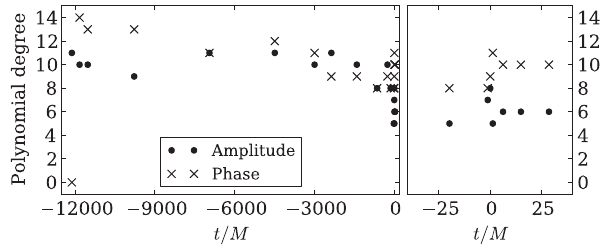
FIG. 13. The optimal degree of each polynomial from a least squares fit at each empirical time. Out of a possible maximum of n 19 , polynomial degrees between 9 and 14 are most often LS ¼ selected during the inspiral phase. The degree of the first fit for the phase is zero because the initial phases are chosen to vanish for all mass